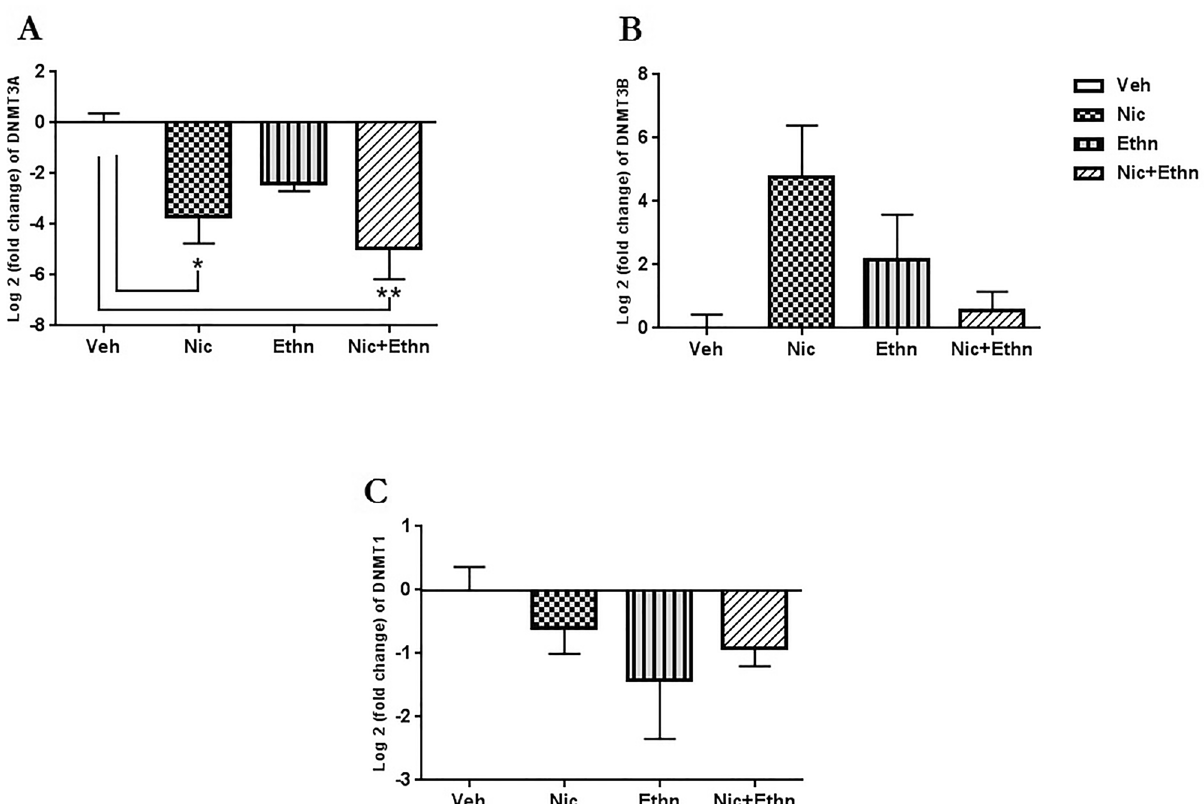
Figure 4. The effect of maternal exposure to nicotine and ethanol, alone and concurrently, on the expression level of enzymes involved in DNA methylation. Real-time quantitative PCR (RT-qPCR) analysis of DNA metyltransferases (DNMT) 1, 3A and 3B gene expression in sperm cells of F1 pups from vehicle ad treated mice. Graphs present mean ± SEM. Data from each gene were normalized to the corresponding value of the housekeeping gene (Actb). Data are exhibited as log twofold changes of relative expression levels of each group compared to the vehicle. * and ** indicate p ≤ 0.05 and p ≤ 0.01.